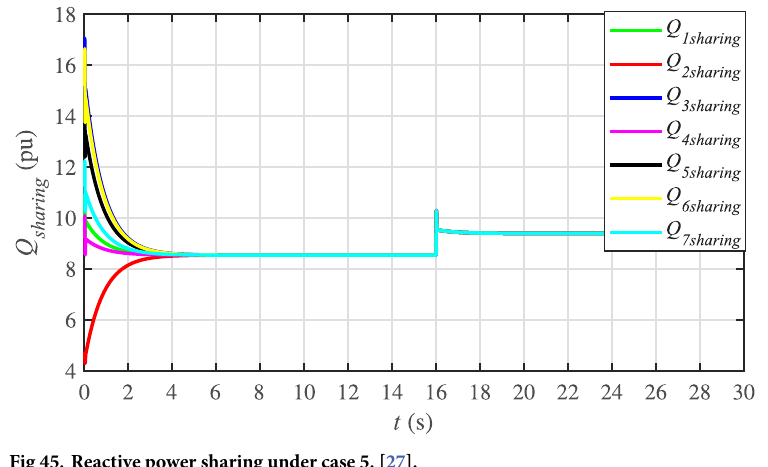
Fig 45. Reactive power sharing under case 5. [27].